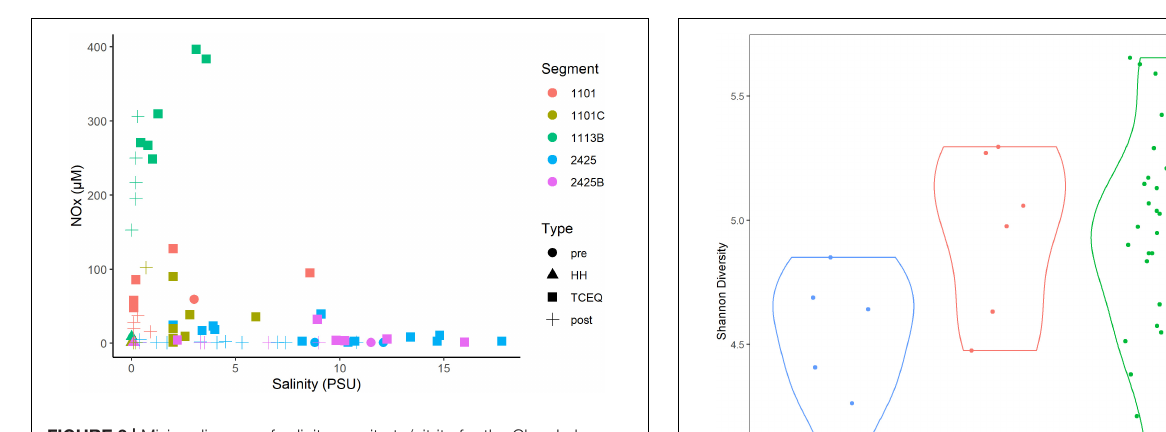
FIGURE 3 | Mixing diagram of salinity vs. nitrate/nitrite for the Clear Lake system. Note DIN data is not available for the sample collected before HH from waterbody segment 1113B. Segments and types are as Figure 2 . Figure was generated with scripts in Supplementary File 3 .